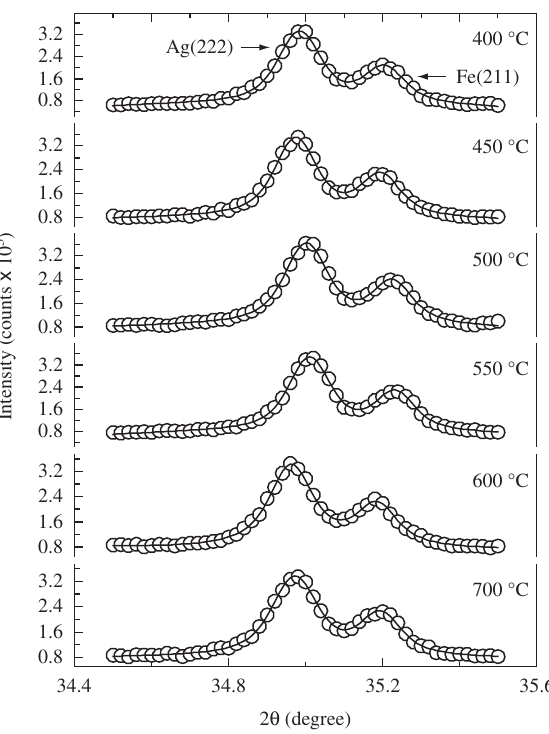
Ag granular alloy 10 90